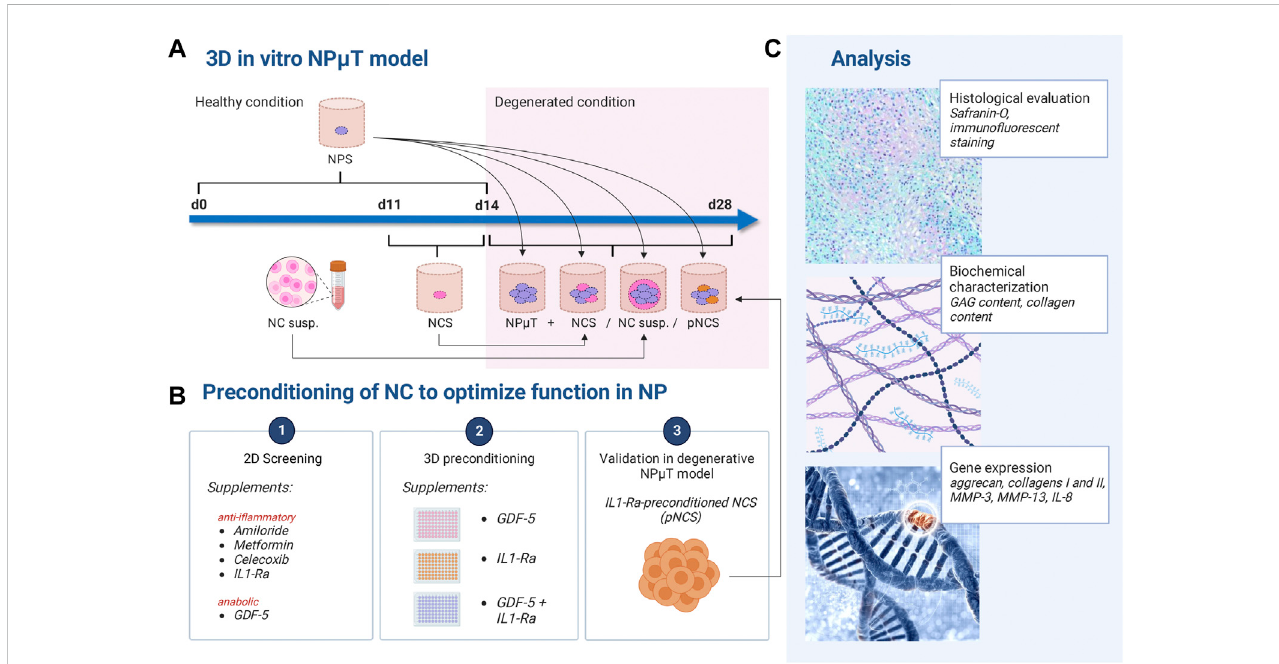
FIGURE 1 Experimental design. (A) NP microtissue (NP μ T) model: single spheroids were generated by culturing NC (NCS) and NP cells (NPS) for 3 days or 2 weeks respectively, in healthy condition. Afterwards, NPS were pooled with NCS/NC to form NPµT (+ NCS/NC susp). (B) NC were preconditioned with anti- in fl ammatory or pro-anabolic compounds in (B1) 2D culture and (B2) 3D culture. (B3) IL-1Ra-preconditioned NCS (pNCS) were implemented in the NPµT model. (C) Histological, biochemical, and gene expression analyses were performed. Created with BioRender.com.